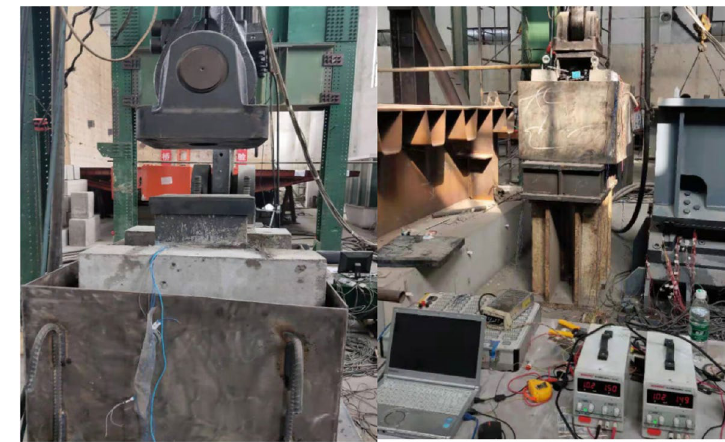
Fig. 8 Loading diagram of the corrosion fatigue group